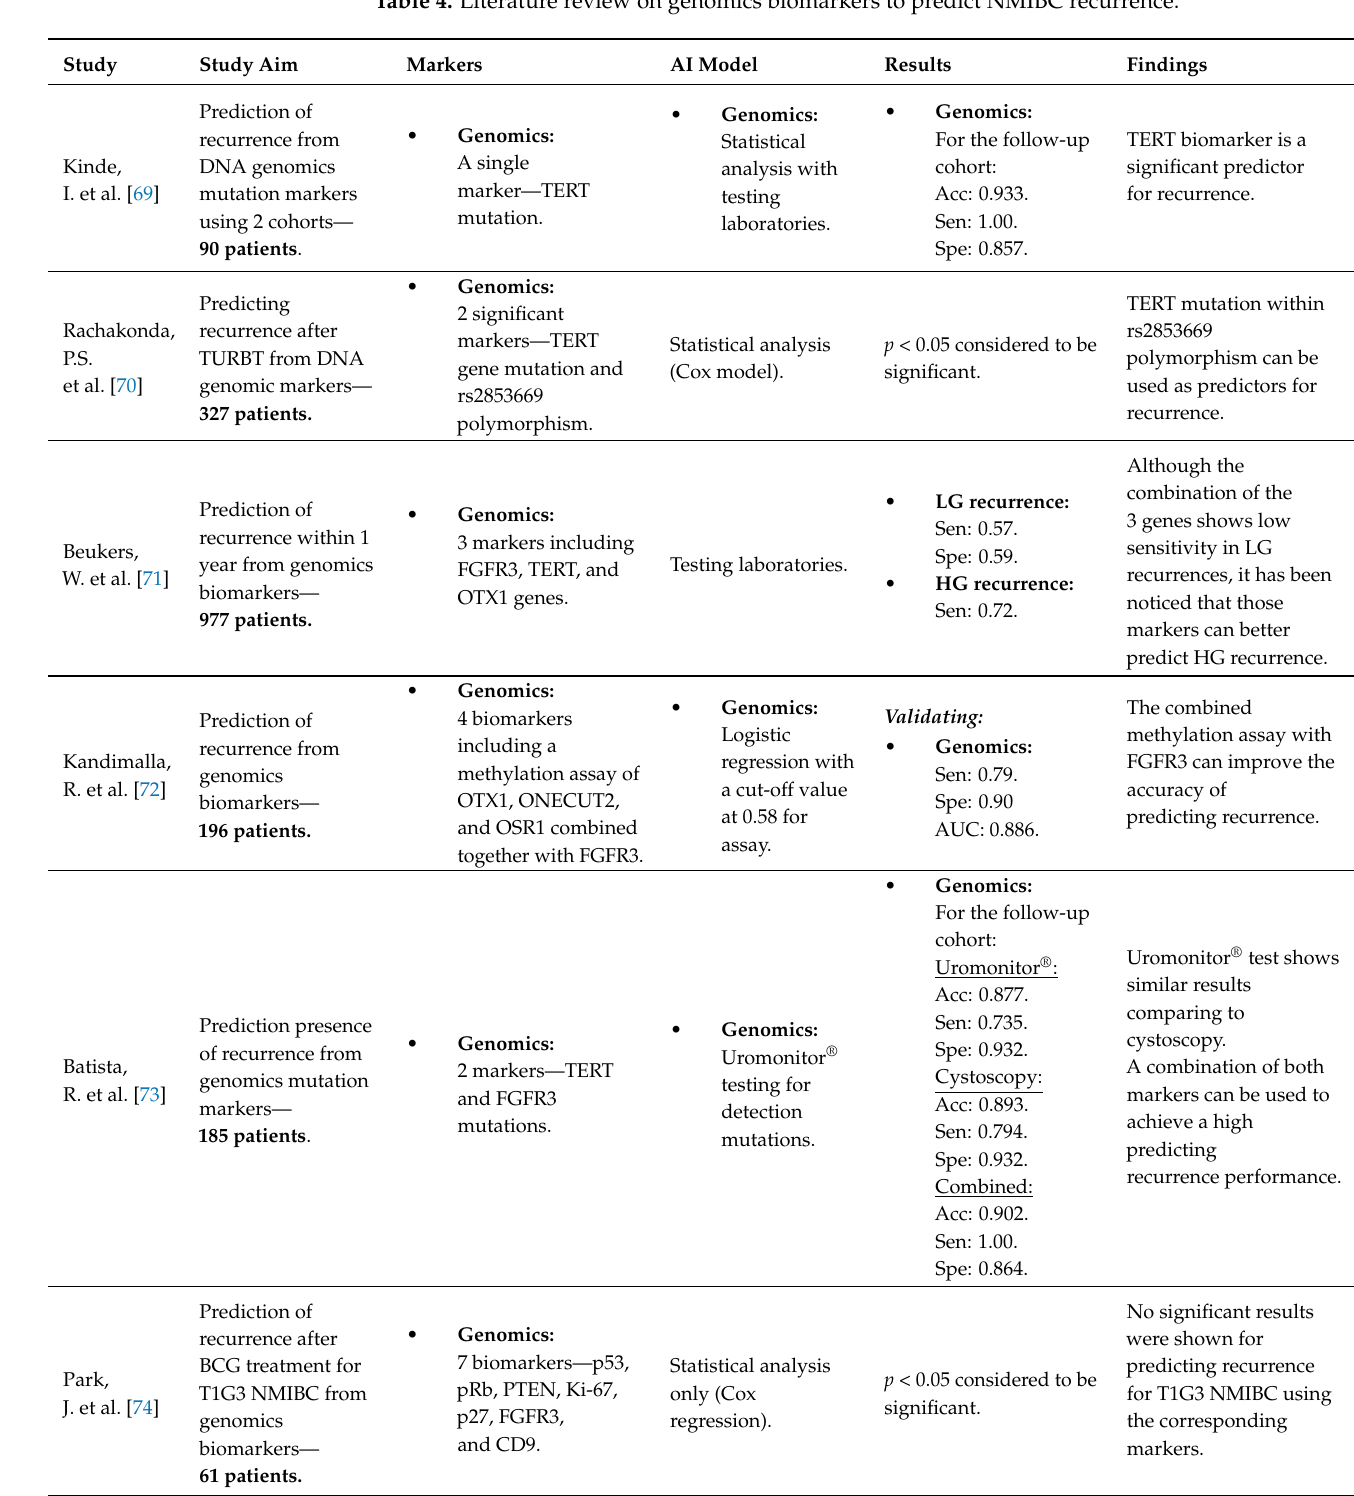
Table 4. Literature review on genomics biomarkers to predict NMIBC